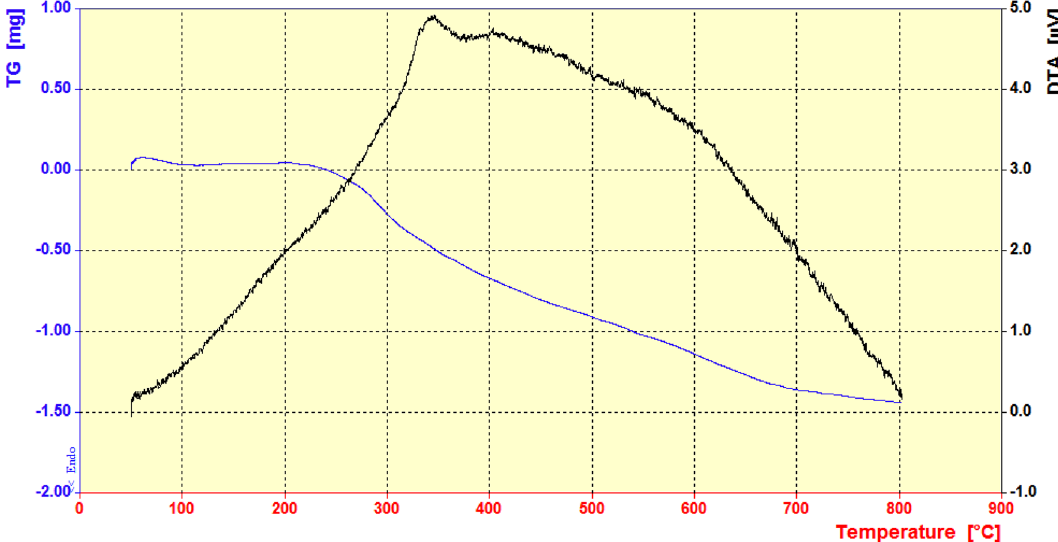
Figure 3. TGA and DTA curves of the Cu@APS-TDU-PMO nanomaterial ( 1 ).